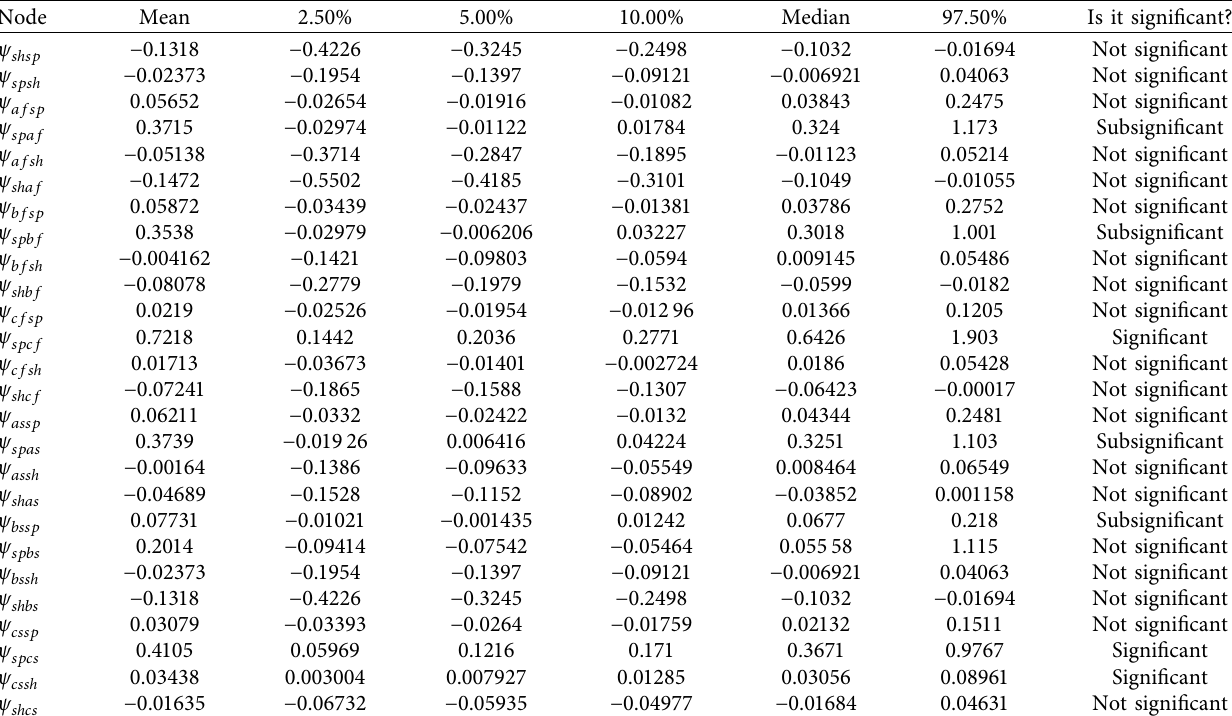
Table 6: Volatility spillover parameter estimation result between stock and oil.